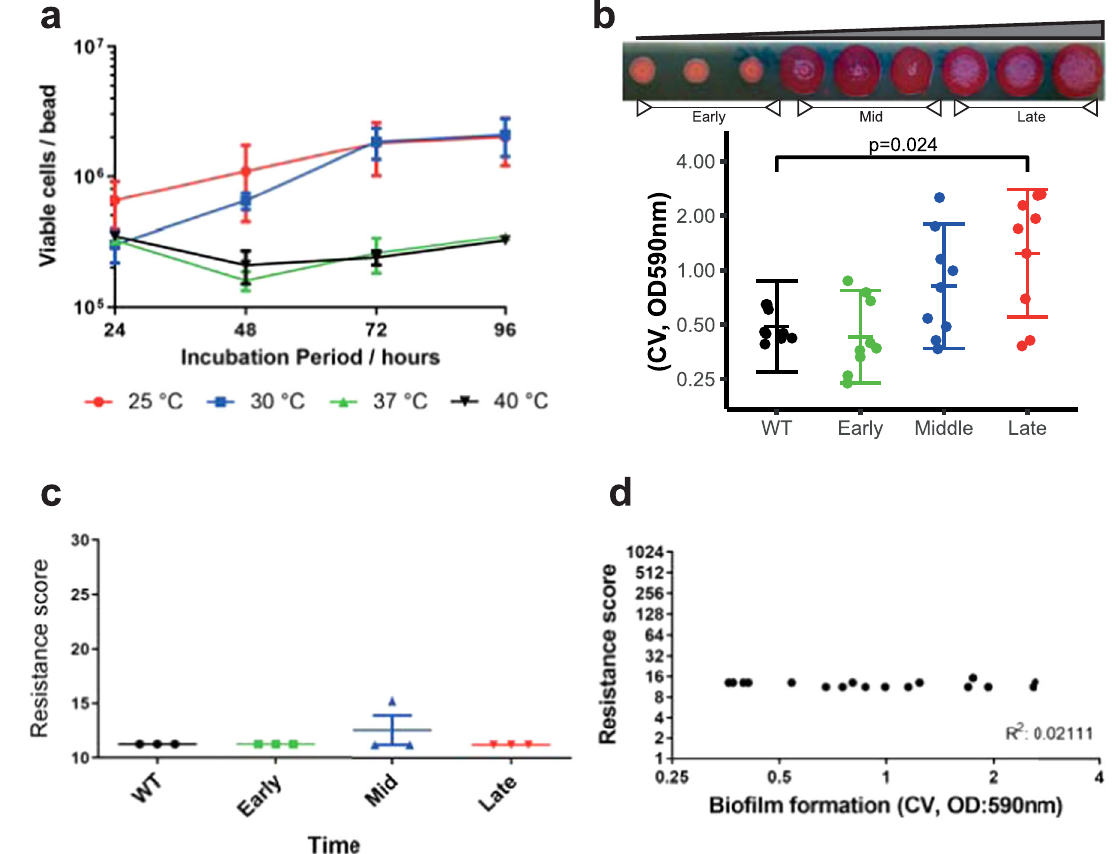
Fig. 2 Bio fi lm model validation. a Optimal conditions were determined by the strain ’ s capacity to form bio fi lms over time, at different temperatures. Maximum cell carriage was achieved at 72 h at either 25 or 30 °C. Dots indicate average from four replicates and error bars show standard error. b Bio fi lm formation in control lineages increased over time as seen by visualisation on Congo red-agar plates and by the Crystal Violet assay (OD: 590 nm). Each dot represents single-cell strains isolated from different timepoints; experiments included three lineages each with three independent replicates. Error bars re fl ect estimated ± one standard error. c Control bio fi lms adapted without drug stress over time showed no changes in antimicrobial susceptibility (shown as ‘ resistance score ’ ; an additive value of all MICs determined for each strain). Data shown are from control lineages from a representative experiment. d No correlation was observed between biomass formation (calculated using the CV assay) and resistance score. Data shown are aggregated from the control lineages from all three drug exposure